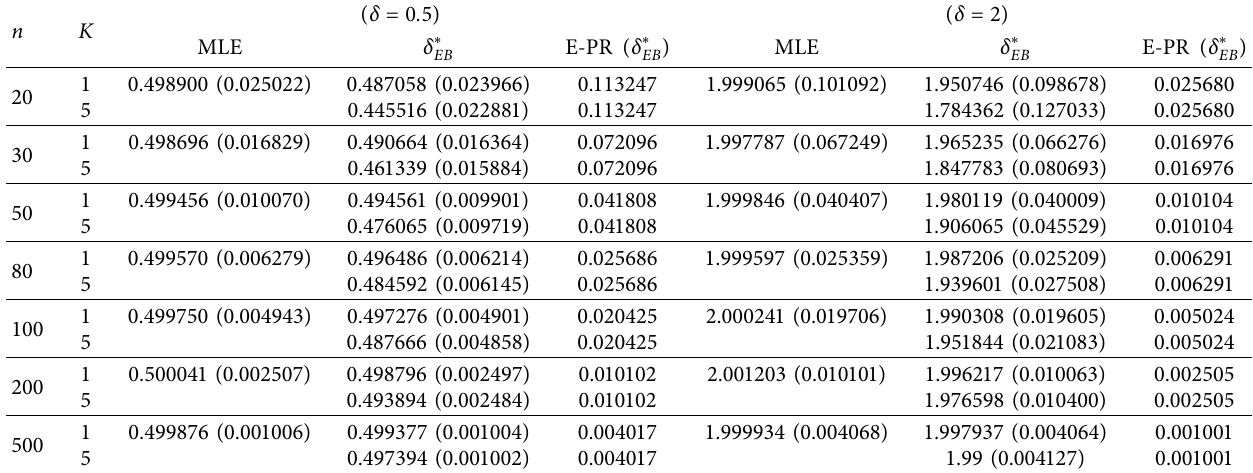
Table 8: E-B and E-PR estimates of SLELF.